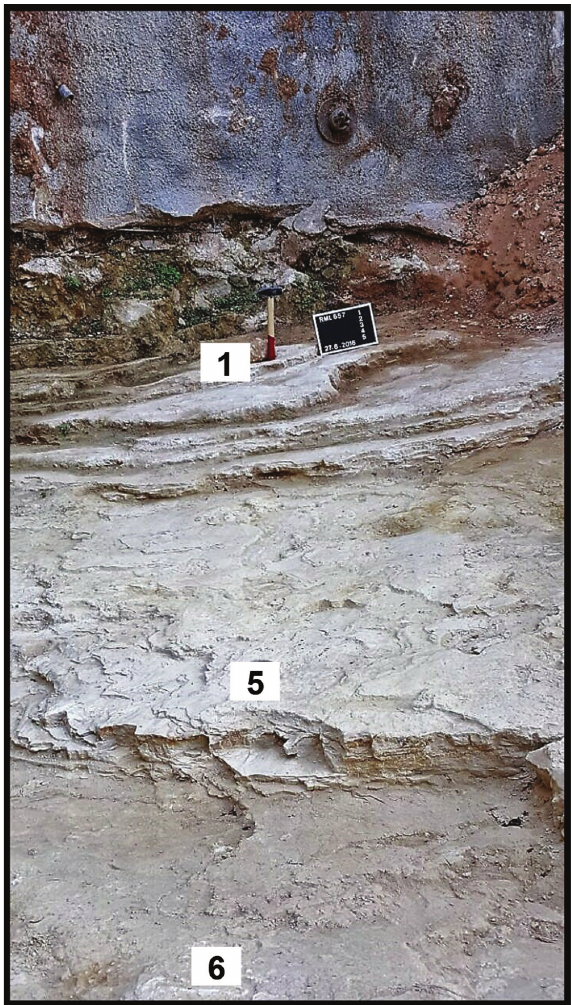
inner platform, lagoonal sediments (Figs 1, 4). These deposits (site 6) include reworked Cretaceous a Miocene brown bed (30 cm) of planktonic foraminifera, and an in situ planktonic foraminifera assemblage not older than Late cross-laminated carbonates resting Miocene, PZ N17 (8.6 Ma). however, the presence of S. subdehiscens (Blow) , Truncorotalia conformably above thinly cross crassaformis (Galloway and Wissler), Globorotalia inflata (d’Orbigny) and Orbulina universa laminated Priabonian strata of 15–20 cm chalky white carbonates. Base (d’Orbigny) indicate a Late Miocene to early Pliocene age range (PZ N17 – N19, 8.6 – 3.8 Ma, see layer 5 in the foreground is the fossil [7, 11]). The argillaceous carbonates’ occurrences suggest a marine incursion filling the topographic fish layer within the Priabonian low between the two east and west uplifts of North Beirut (achrafieh and West Beirut) (see location map Figs 1, 4). To the east of these inner platform sediments, a shoreline carbonate section (site 2) forms an apron of sediments against the rising northern foothill of achrafieh. The uncovered bedrock of the site 2 excavation exposes a shoreline sequence of shore to backshore layers at the base and a beach-rock sedimentary structure on top (Figs 2, 6).